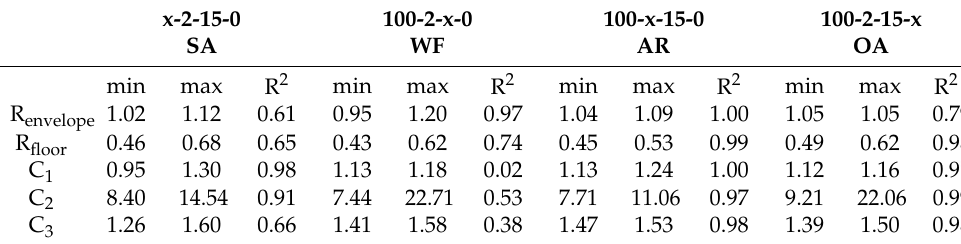
Table 10. Linear regression of estimated/calculated parameters for light-structured